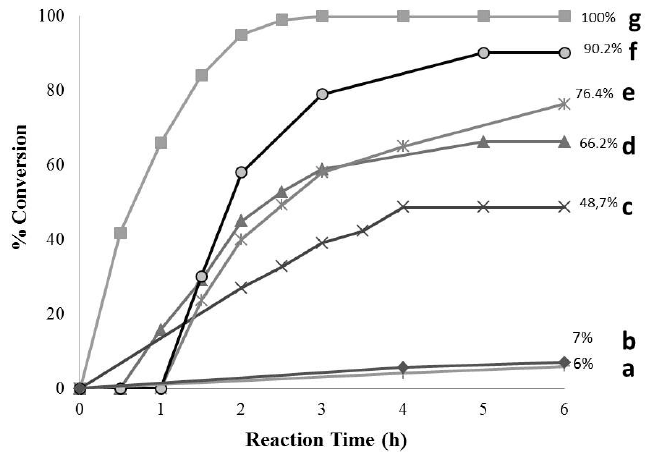
Figure 7. Benzyl alcohol conversion as a function of reaction time: ( a ) Without catalyst, ( b ) AC, ( c ) Co 3 O 4 , ( d ) Co 3 O 4 /RB3, ( e ) Co 3 O 4 /CNR, ( f ) Co 3 O 4 /RX3, and ( g ) Co 3 O 4 /G60.